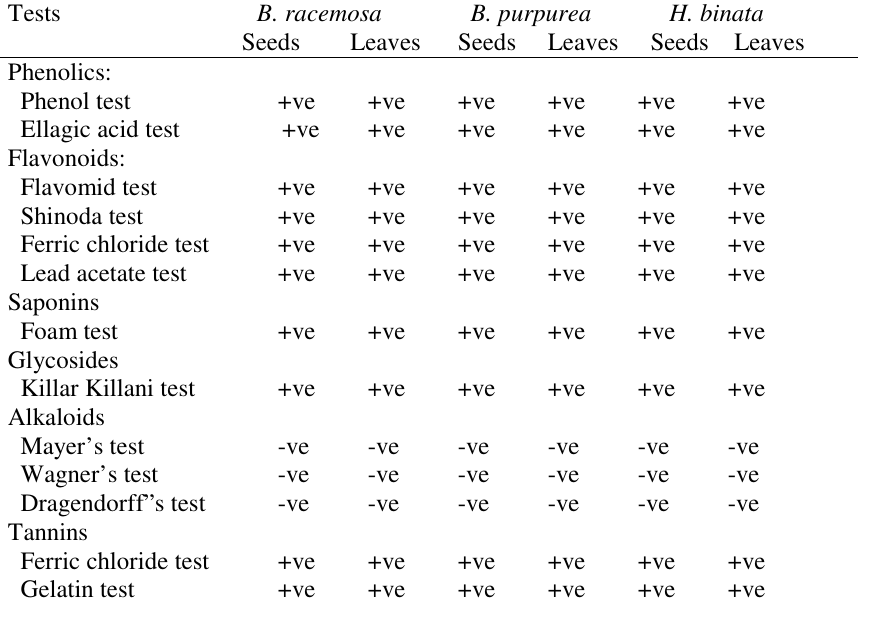
Table 1 . Data of preliminary phytochemical analysis Tests